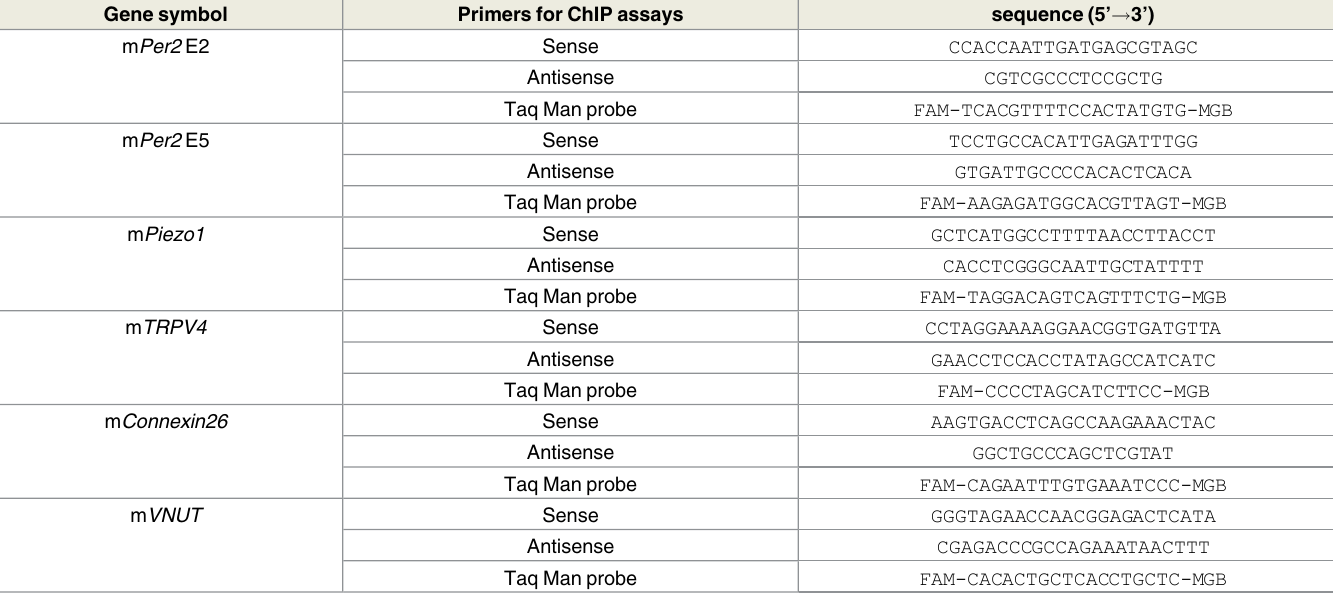
Table 2. Primer and Taq Man probe sequences. Gene